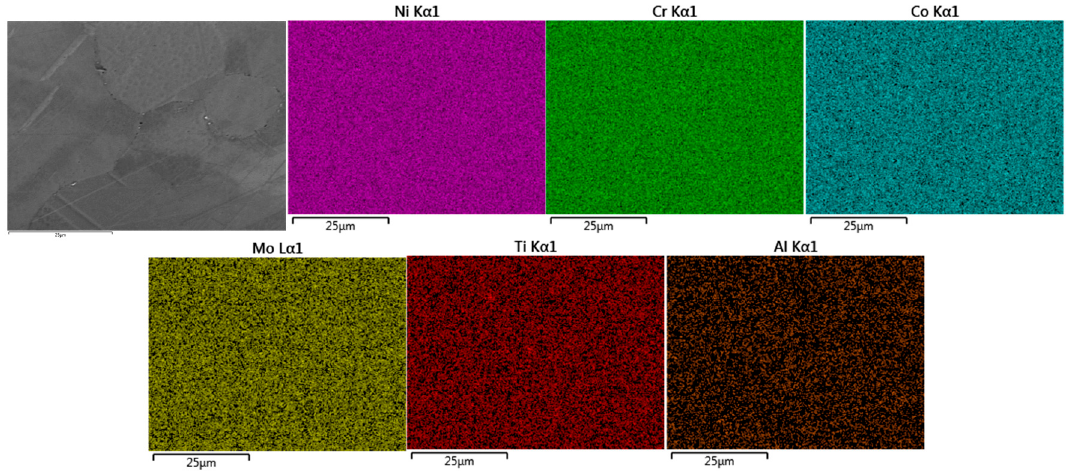
Figure 10. EDS analysis of PB-DLD HSHT C263 microstructure.